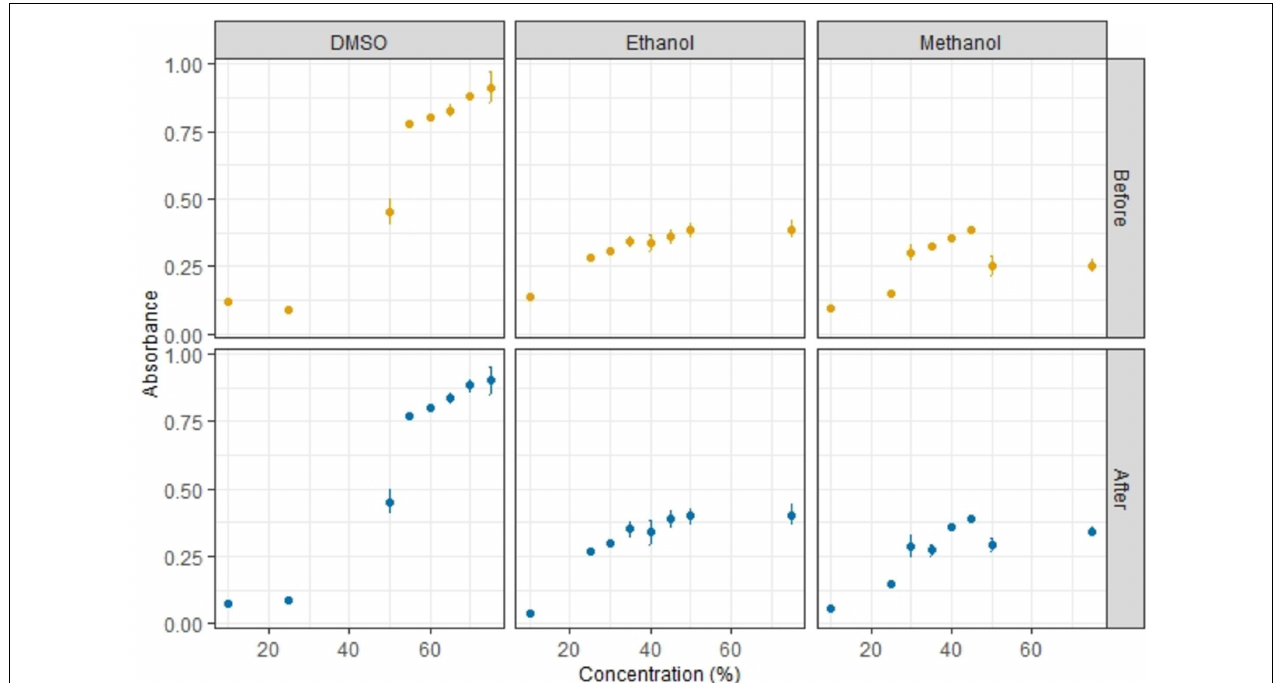
FIGURE 1 | Absorbance with 10 µ g/ml NR in the different solvents (before and after incubation).